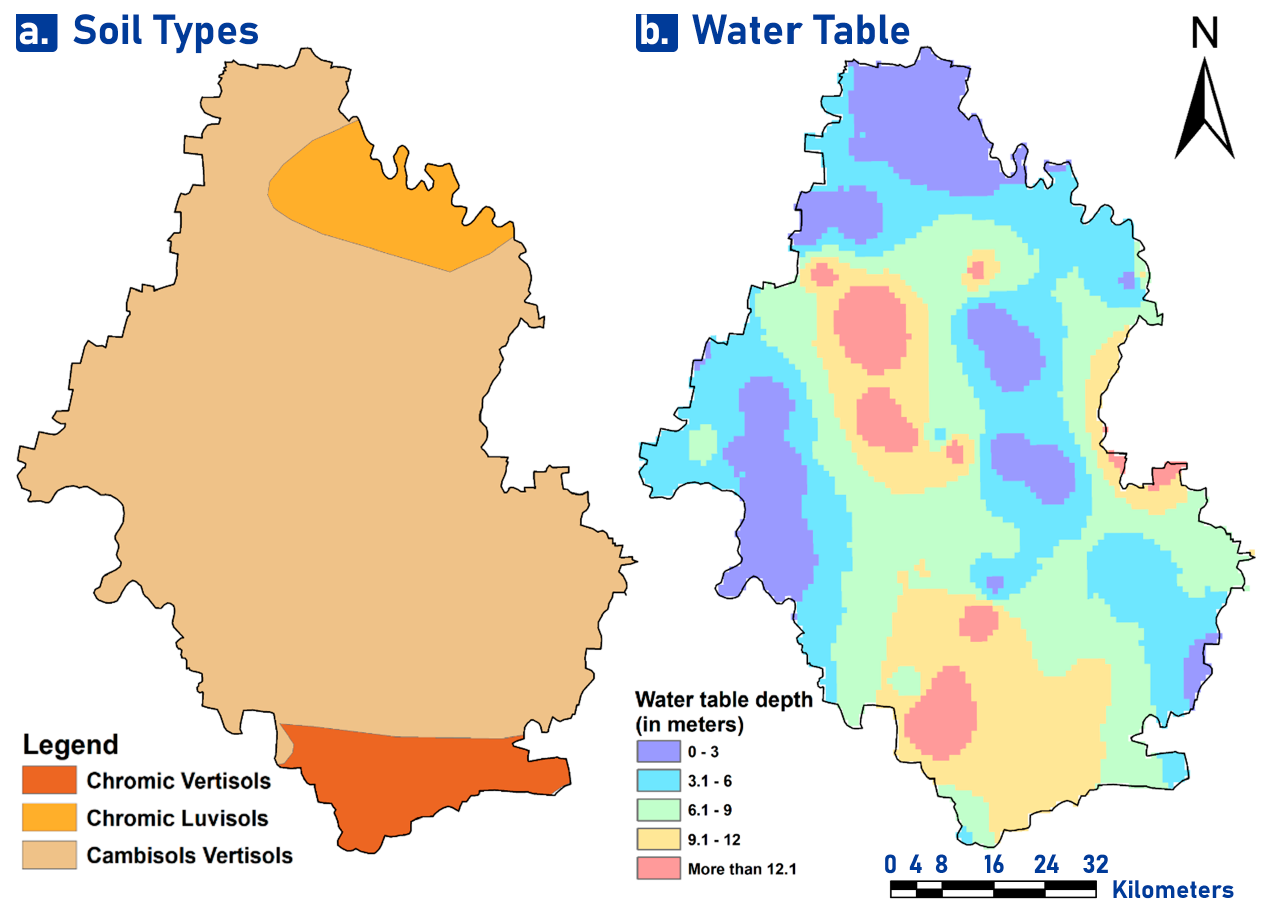
Figure 4. Factors affecting groundwater potential: ( a ) soil types, ( b ) water table.